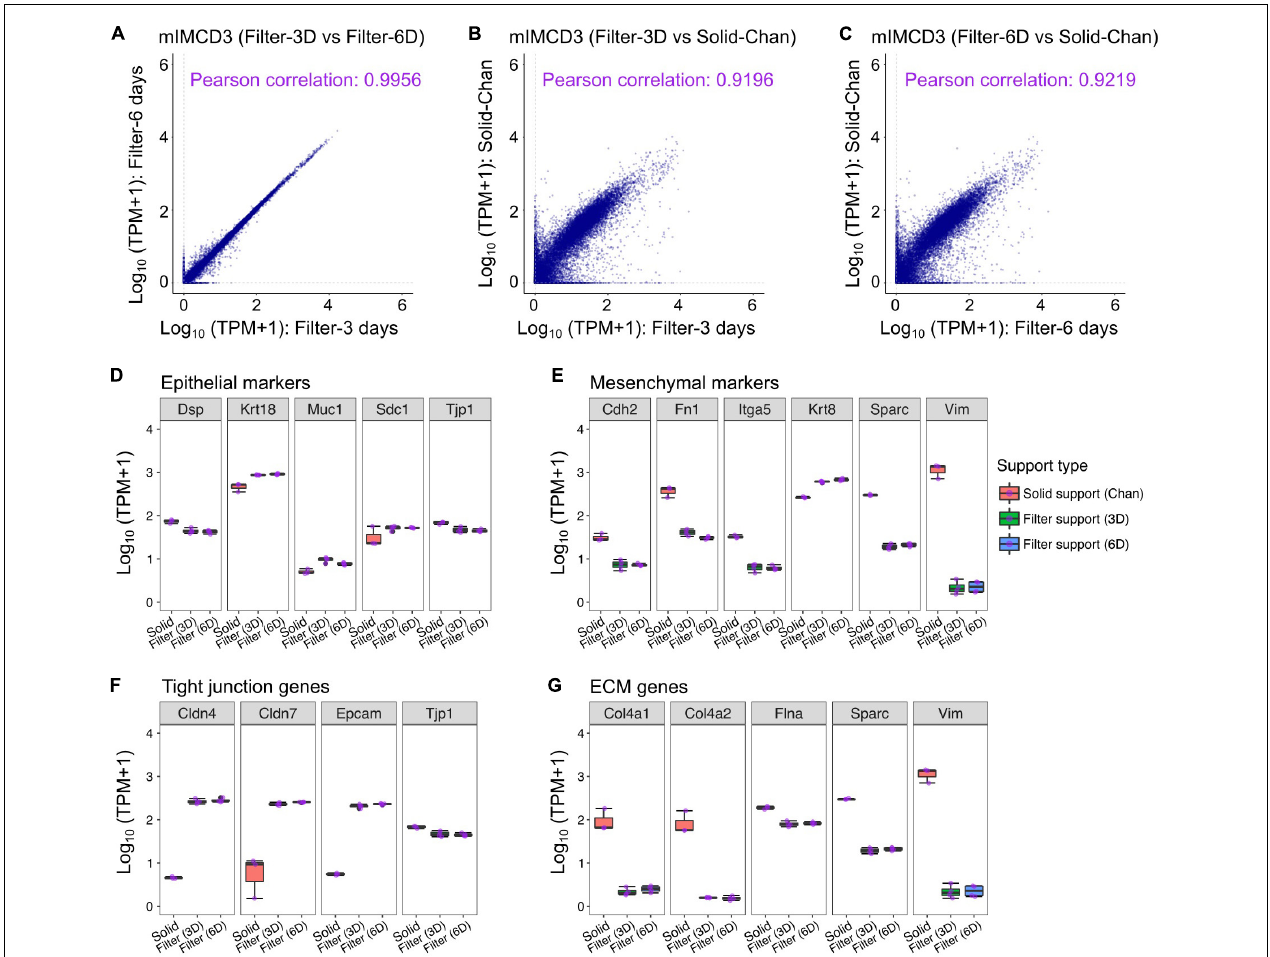
FIGURE 1 | Transcriptomic characteristics of renal epithelial cell line mIMCD3 in different culture conditions. (A) Transcriptomic correlation was assessed in mIMCD3 cells grown on the permeable filter supports for 3 and 6 days. (B,C) Transcriptome profiles of mIMCD3 grown on the permeable filter support and the solid support were compared. The transcriptome dataset of mIMCD3 cells grown on the solid support was obtained from GSE97770 (Chan et al., 2018). (D–G) Box plots of gene expression associated with epithelial cell, mesenchymal cell, tight junction formation, and extracellular matrix (ECM) in mIMCD3 cells grown on the solid support (Chan et al., 2018) and the permeable filter